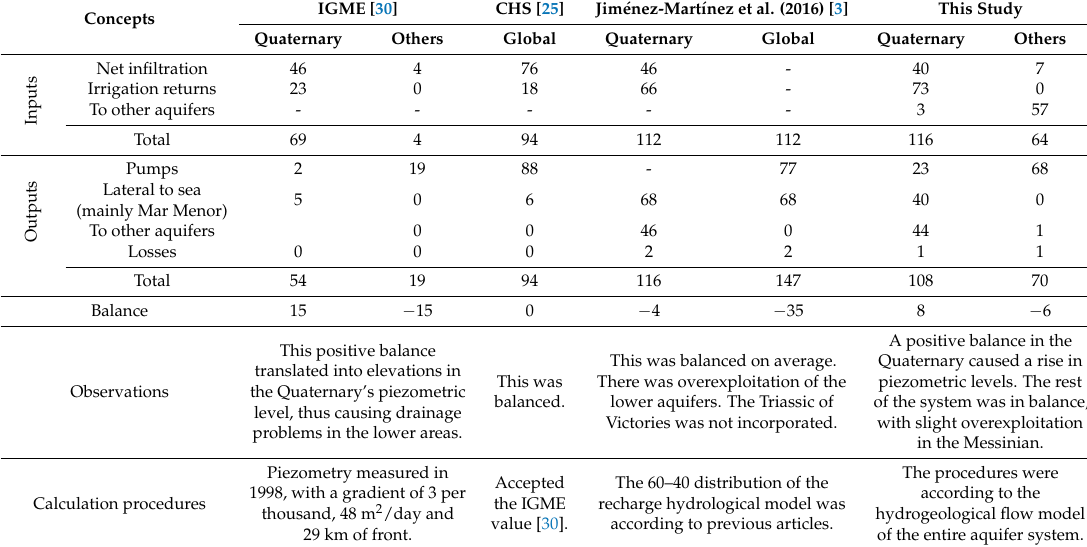
Table 7. Comparative transient-state water balance of the Campo de Cartagena for the models used in this study and in others (Mm 3